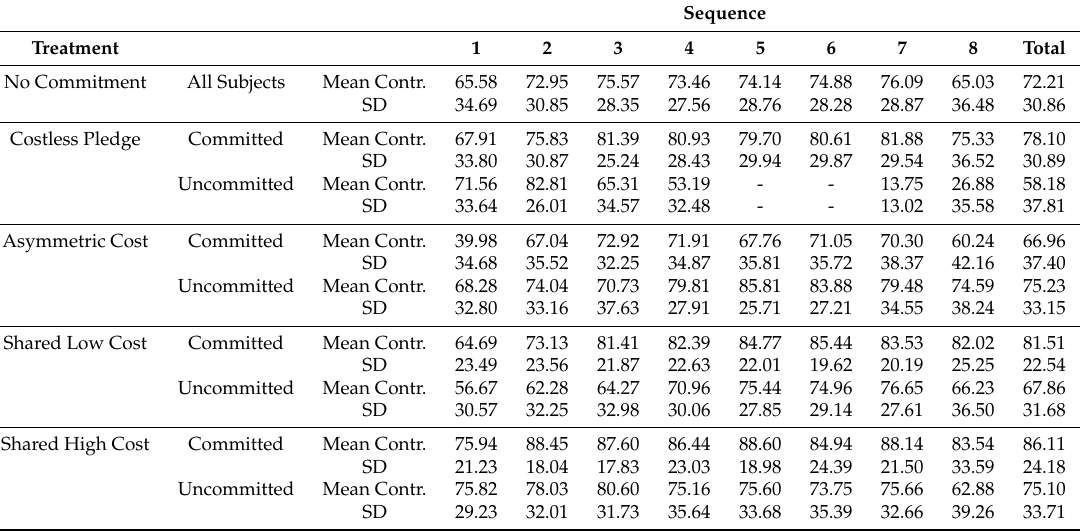
Table 7. Summary of committed subject’s contribution behaviour by sequence and